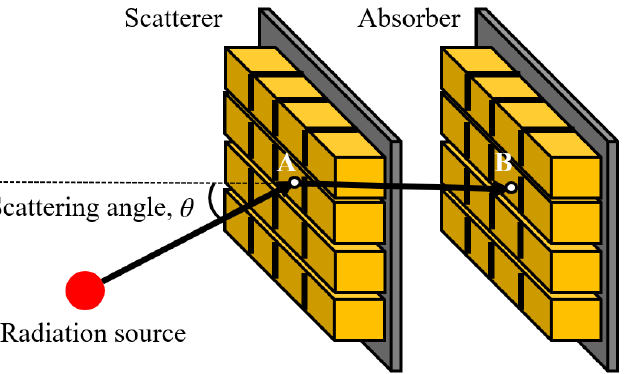
Figure 3. Principle of Compton camera: the Compton camera comprises two layers: scatterer and absorber. Let A and B be the positions at which the gamma ray is deposited on the scatterer and absorber, respectively, while θ is the scattering angle of the gamma ray relative to the straight line connecting A and B